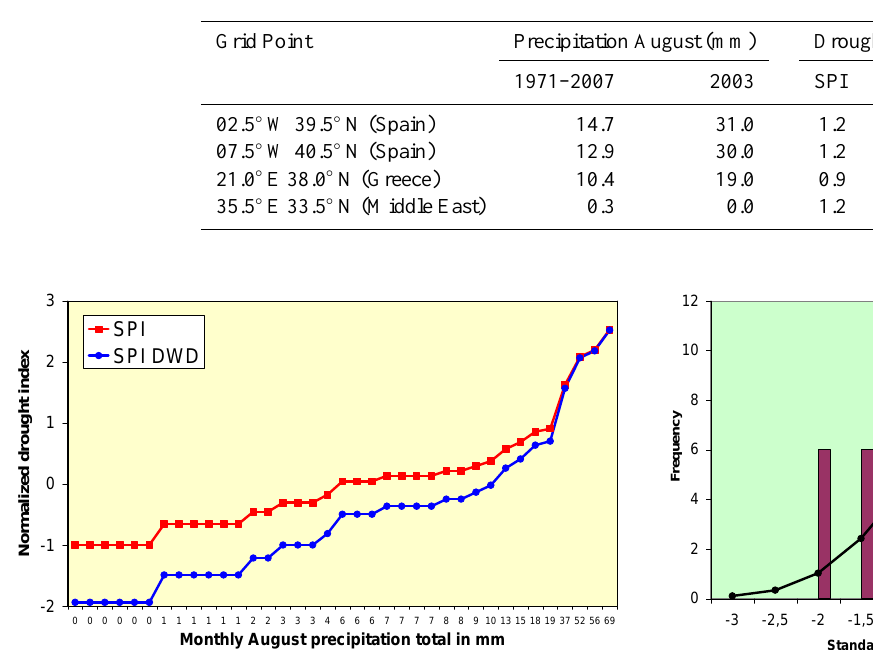
Fig. 3: Frequency distribution of the SPI and the SPI DWD for the same data as in Fig. 2, compared with the corresponding normal distribution.